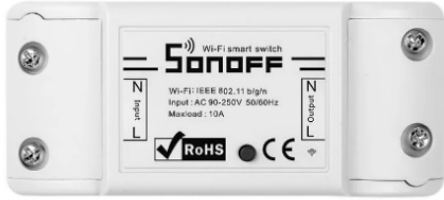
Figure 8. Sonoff Wi-fi Smart Switch .